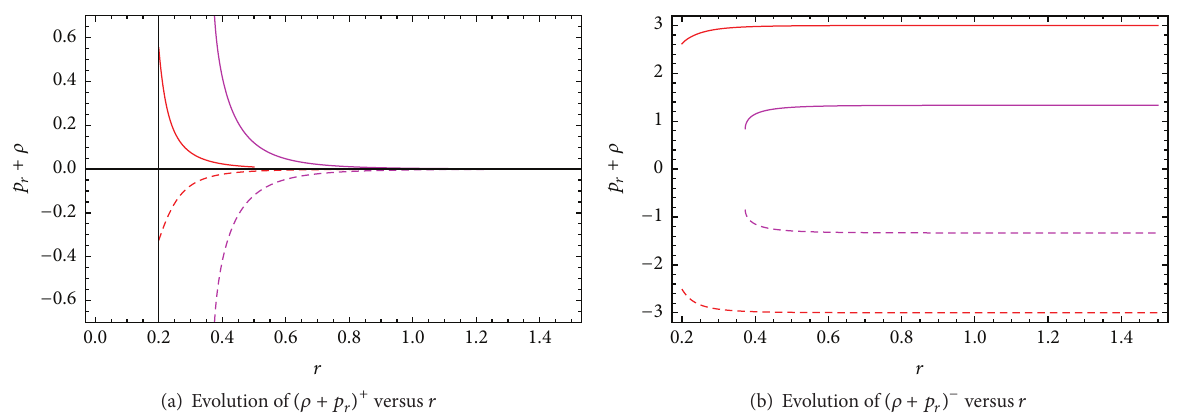
Figure 3: Plots of (a) 𝜌 + 𝑝 𝑟 for 𝑠 + and (b) 𝜌 + 𝑝 𝑟 for 𝑠 − versus 𝑟 in Gaussian distribution for 𝑛 = 5 , 𝜖 = 1 (red), 𝑛 = 5 , 𝜖 = −1 (red dashed), 𝑛 = 6 , 𝜖 = 3 (purple), and 𝑛 = 6 , 𝜖 = −3 (purple dashed).